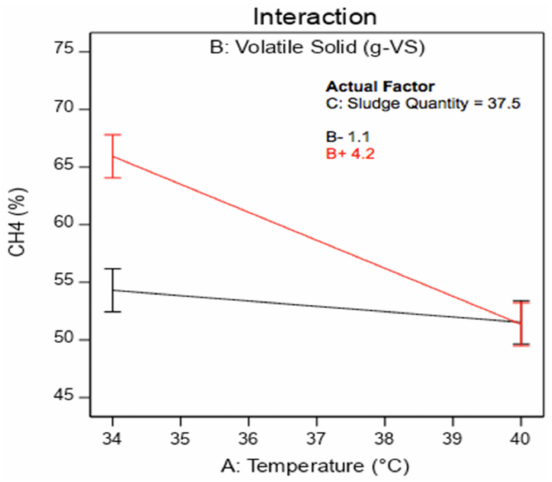
Figure 28. Interaction Plot shows the effect of interaction between temperature and volatile